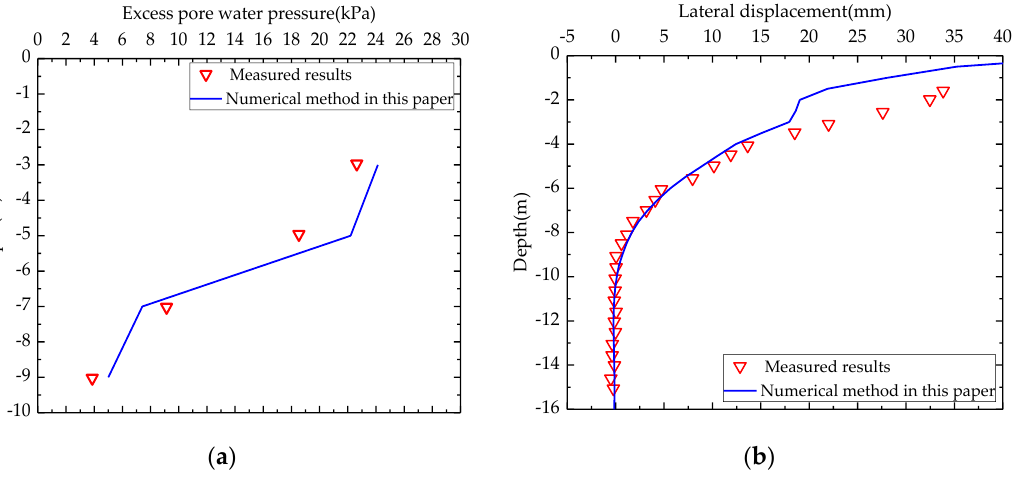
Figure 4. Comparison with the field results for the case of 2500 kN · m tamping energy [17]. ( a ) Excess pore water pressure versus soil depth; ( b ) Lateral displacement versus soil depth. The FEM model contained 2000 solid meshes and 2000 fluid meshes, respectively. The whole model was 20 m in width and 30 m in height and divided into three layers. The FEM analysis was performed using a four-node axisymmetric quadrilateral element with reduced integration. The groundwater level was set on ground surface as reported [26]. The vertical boundaries were fixed in the horizontal displacement, horizontal and vertical constraints were fixed at the bottom, the drainage boundary was free on the foundation surface, and the undrained boundary conditions were set at the bottom and side boundaries. Following the field tests, the tamper radius (R) and drop height (H) were kept as 1.2 m and 20 m, respectively. The tamping energy of 3000 kN · m was simulated, and the blows were 10 at each impact point. A stable time step of 10 − 6 s was used in the explicit analysis. In Figure 6, the simulated results and the measured data of DC tests in layered soils are compared, plotting the relative density of the soil against the ground depth. It is shown that the simulated and measured results are in a good agreement, which indicates that the fluid–solid coupling FEM method with the improved cap model is reliable for the analysis of the DC problem in layered